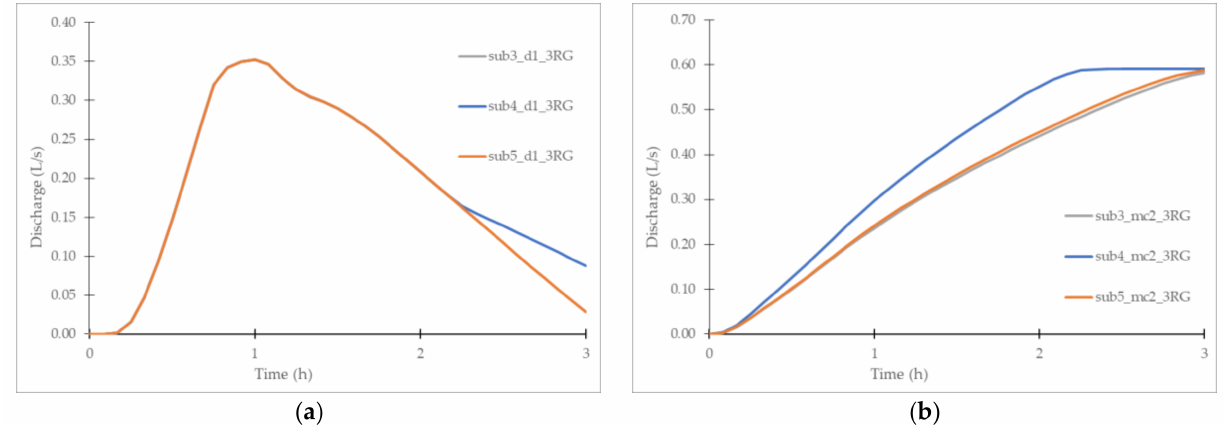
Figure 8. The results of the 3RG scenario, which includes three types of a rain garden, for DE_Q5_P50: ( a ) depth of water stored on the surface (d1), and ( b ) soil layer moisture content (mc2).